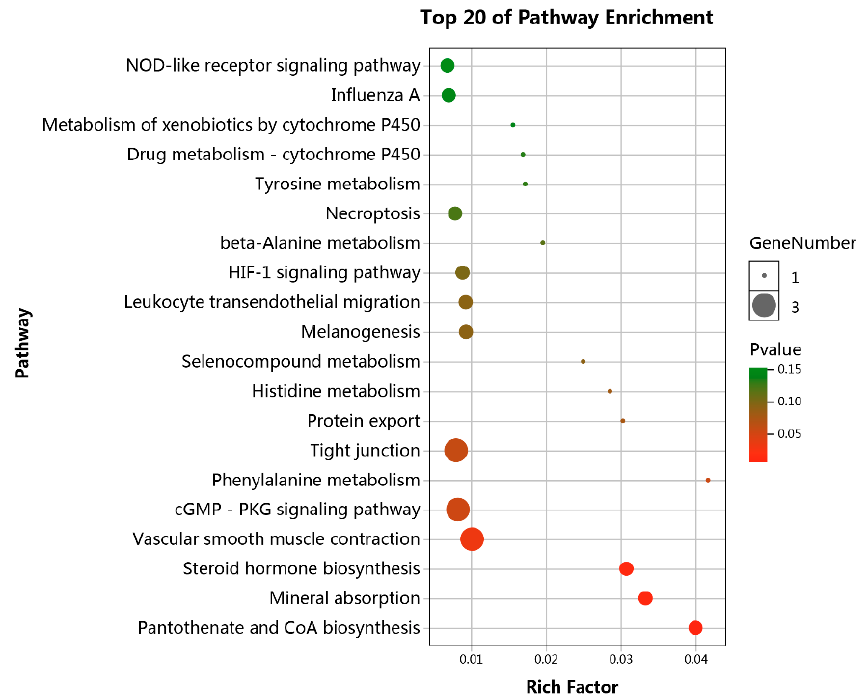
Figure 5. KEGG pathway analyses of mRNAs involved in the lncRNA-related ceRNA network.